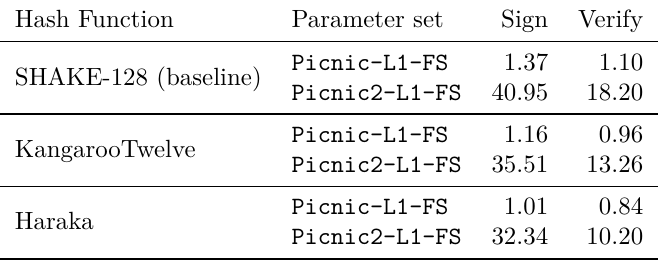
Table 5: Benchmarks with different hash function